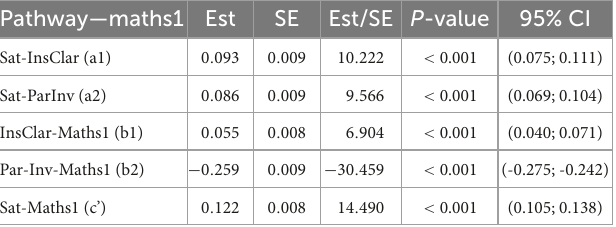
TABLE 3 Results of direct effects.